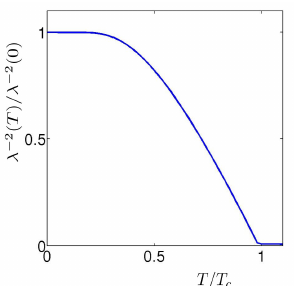
Figure 4: Computed superfluid density as a function of temperature. The